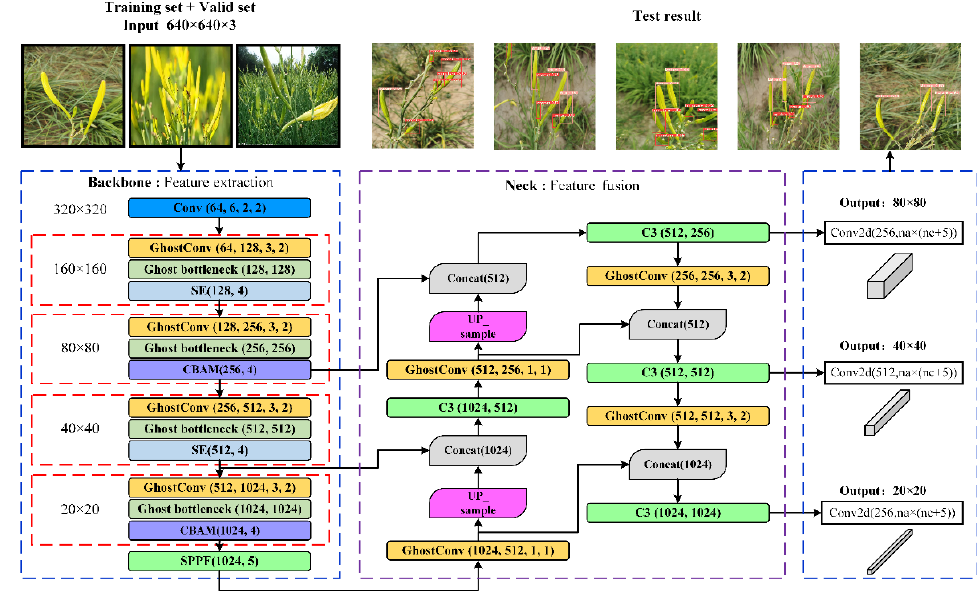
Figure 6. GGSC YOLOv5 model structure.